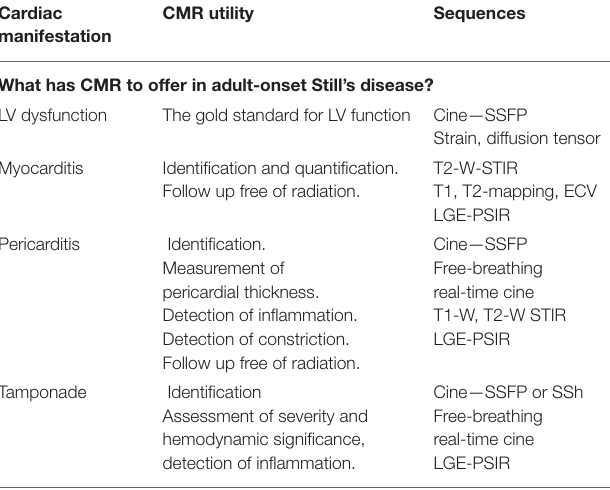
TABLE 6 | CMR offerings to the